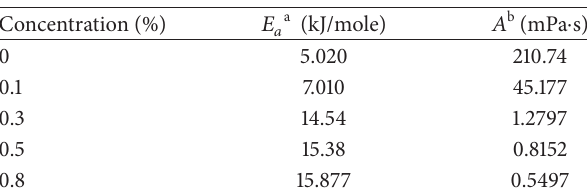
Table 1: Activation energy and pre-exponential factors obtained from Arrhenius model for different surfactant concentrations.